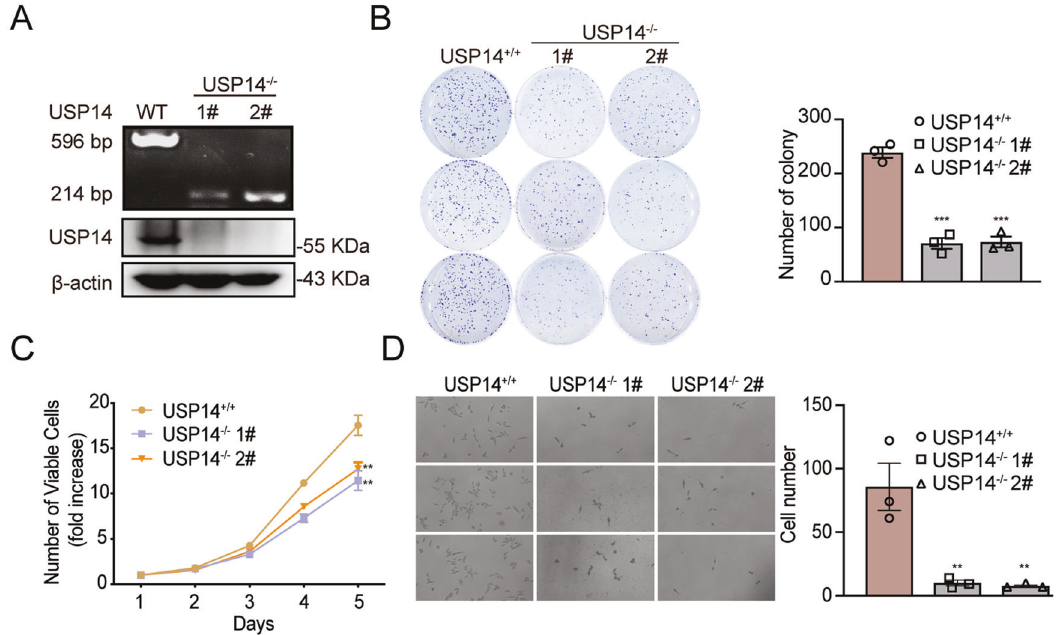
Fig. 2 USP14 regulates colorectal cancer cell carcinogenesis. A USP14 knockout was identi fi ed by genomic PCR and immunoblotting with RKO cells. β -Actin was used as the loading control. B The viability of USP14-depleted RKO cells was determined by colony formation experiment. The number of colonies was record ( n = 3). C The cell proliferation ability of USP14-depleted RKO cells was determined by Cell Counting Kit-8 (CCK-8) assay ( n = 8). D The cell migration ability of USP14-depleted RKO cells was determined by transwell experiments ( n = 3). The data are presented as the means ± SEM. Statistical signi fi cance was analyzed by ANOVA. ** p < 0.01, *** p <